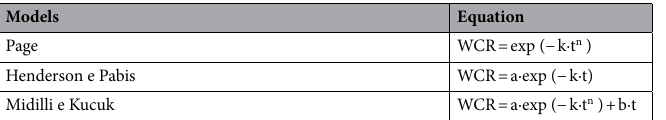
Table 3. Mathematical models used in the analysis of the solar drying process. WCR is the water content ratio (WCR =